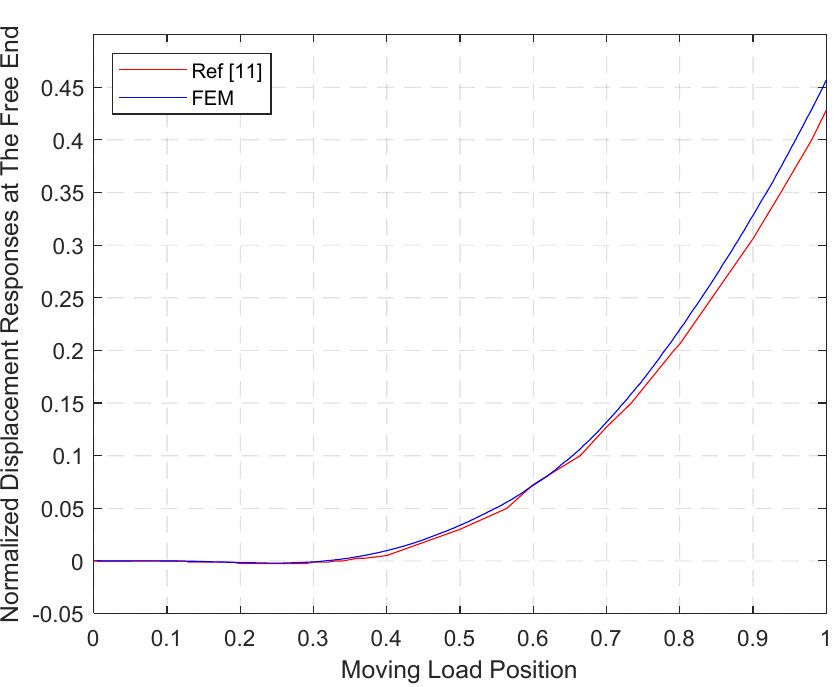
Figure 5. Force deflection response of the modeled cracked beam against analytical response.